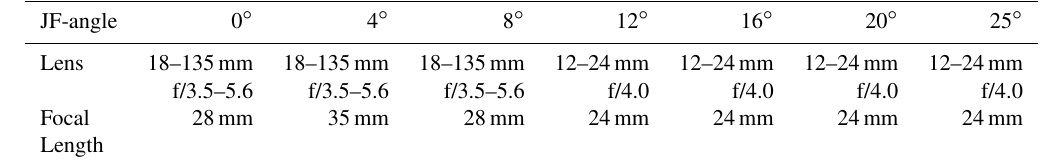
Table 1. Summary of lens types and focal lengths used for top-view photography.